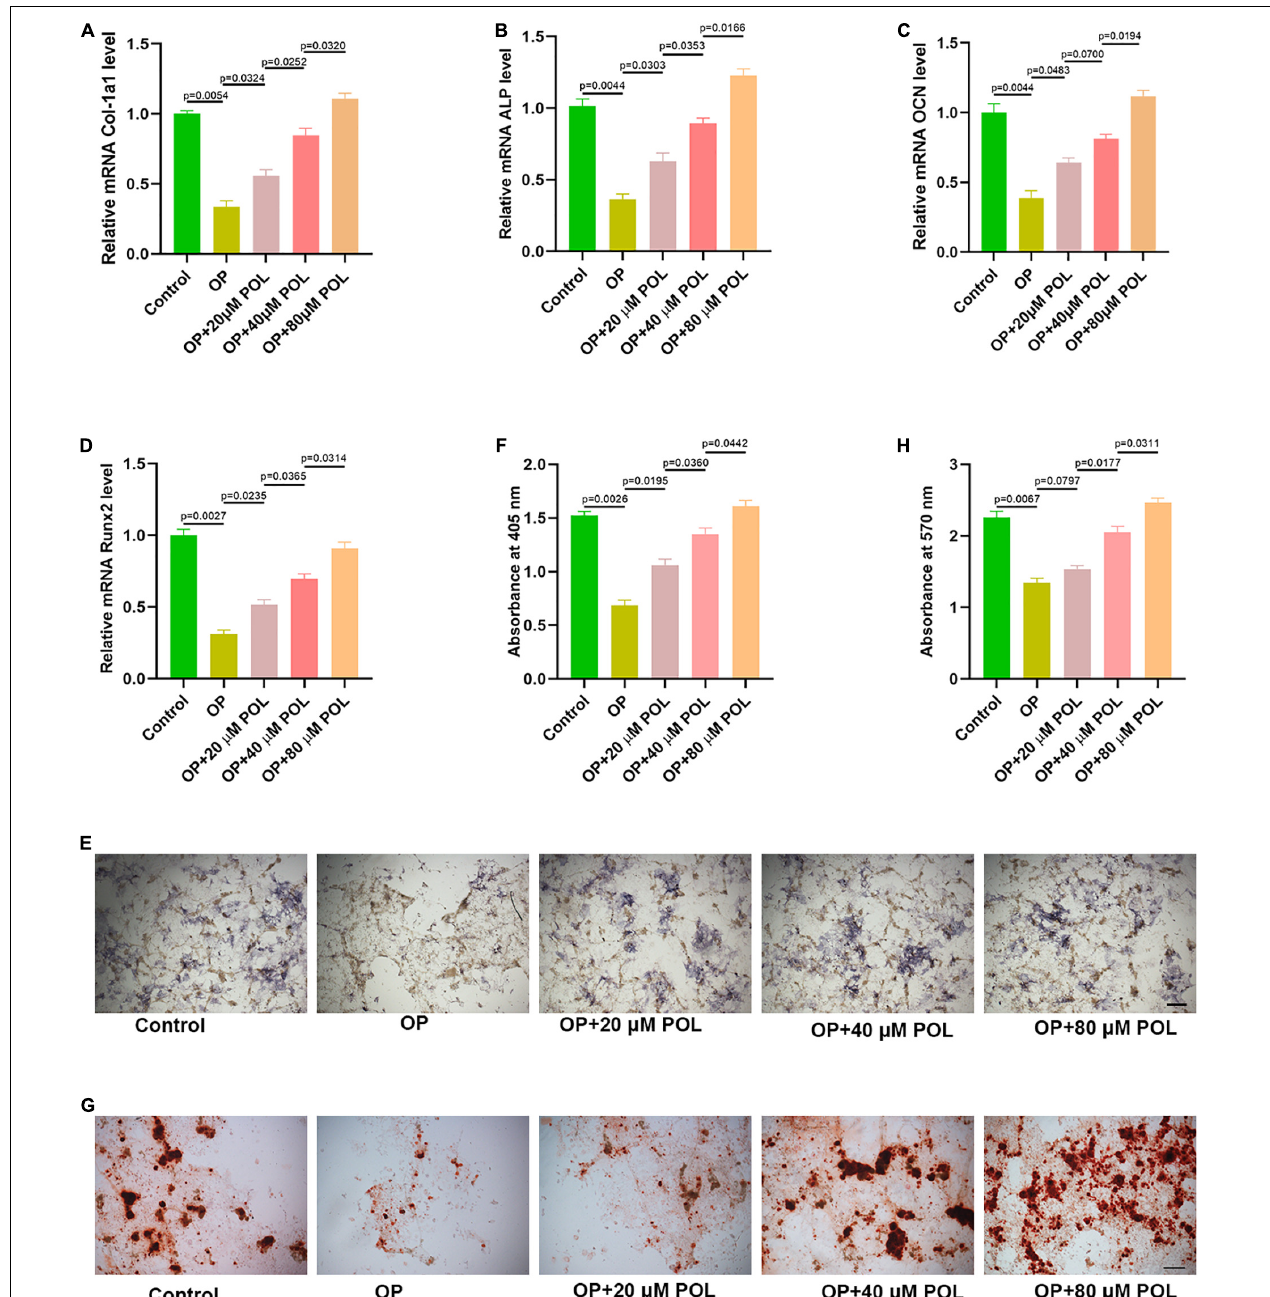
FIGURE 7 | Polydatin (POL) reverses OP in vitro . (A–D) The expression of Col-1a1, ALP, OCN, and Runx2 in the different groups [Control(PBS); OP; OP + 20 µ M POL; OP + 40 µ M POL; OP + 80 µ M POL] was measured using a qRT-PCR analysis. The cellular OP model was performed using DXM; (E,F) ALP staining in MC3T3-E1 following different treatments; (G,H) Alizarin red- calcium staining in MC3T3-E1 following different